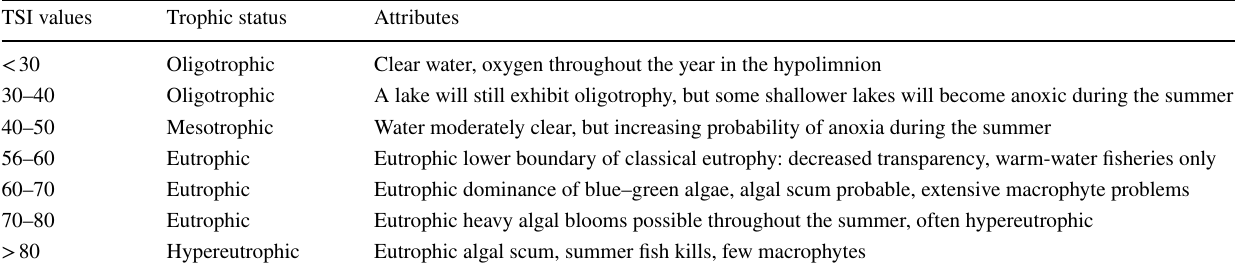
Table 3 Carlson’s Trophic State Index values and classification of lakes (Devi Prasad and Siddaraju 2012) TSI values